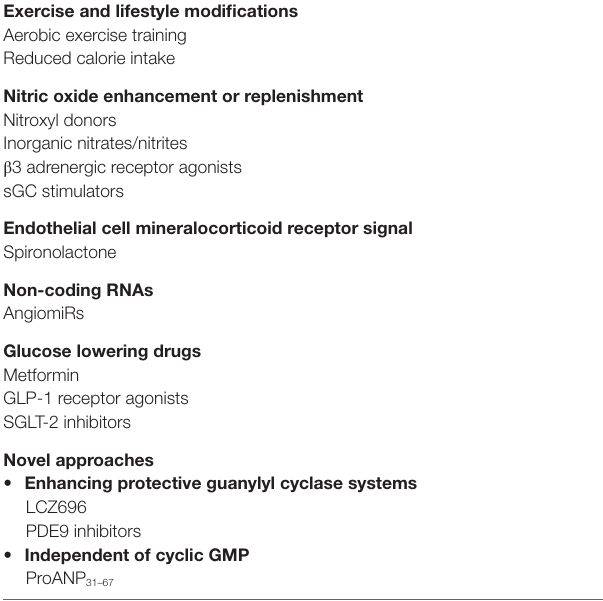
TABLe 1 | Potential targets or approaches for HFpEF. exercise and lifestyle modifications Aerobic exercise training Reduced calorie